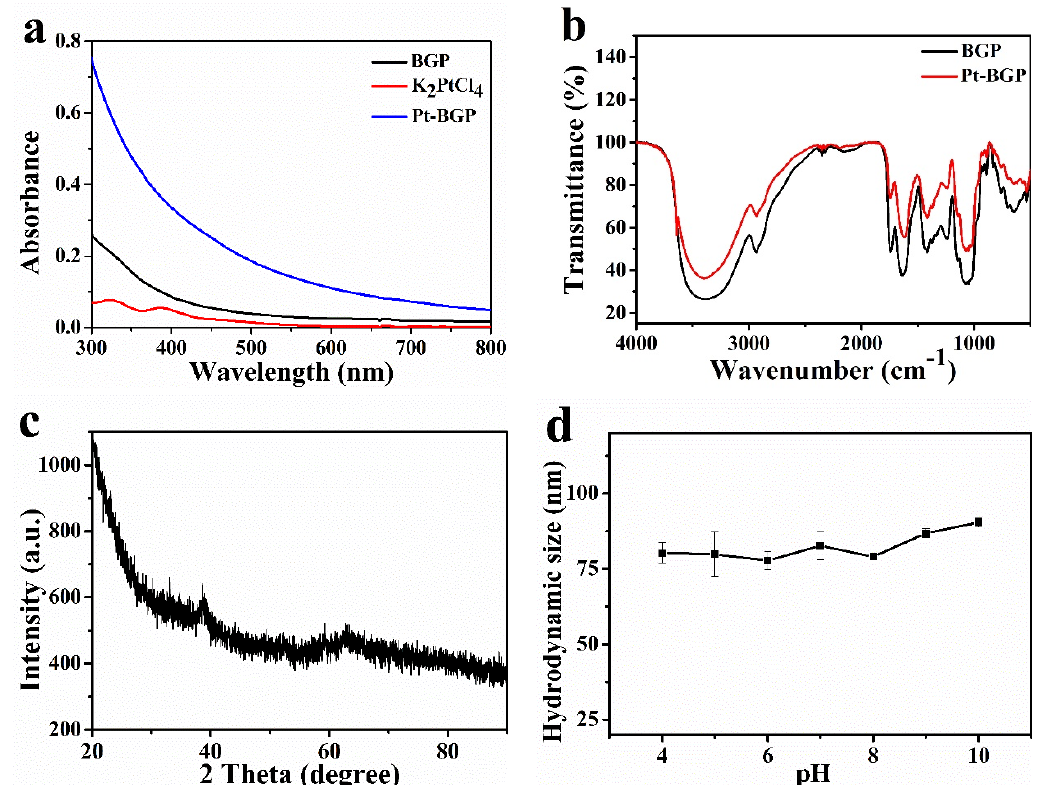
Figure 3. ( a ) UV-Vis spectra of BGP, K 2 PtCl 4 and Pt-BGP NCs; ( b ) FTIR spectra of BGP and Pt-BGP NCs; ( c ) XRD diffraction pattern of Pt-BGP NCs; ( d ) hydrodynamic size of Pt-BGP NCs in different pH solutions.